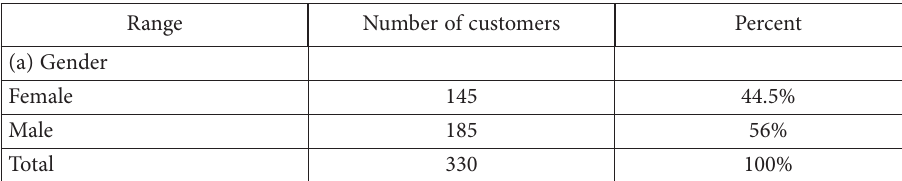
Table 1. Characteristics of